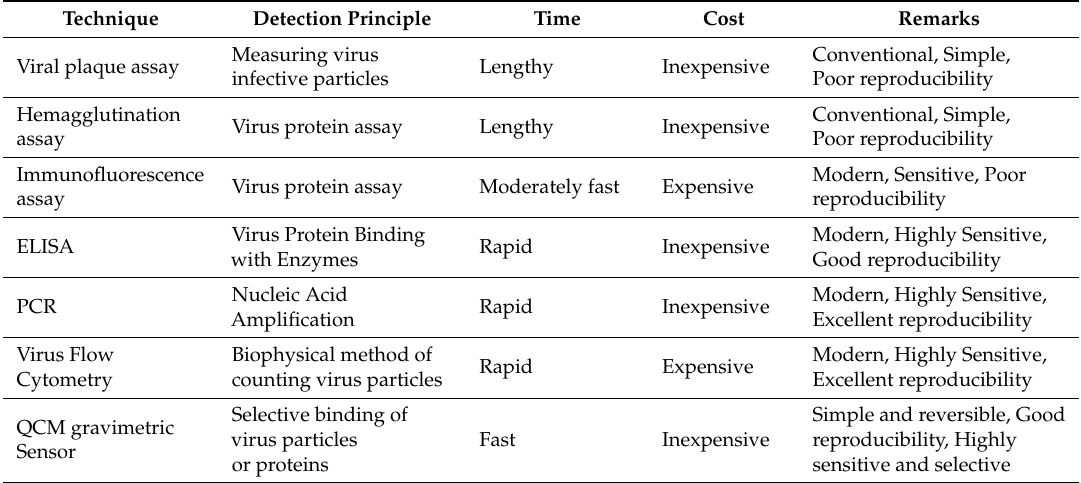
Table 4. A comparison of different virus recognition techniques with QCM based gravimetric sensors.